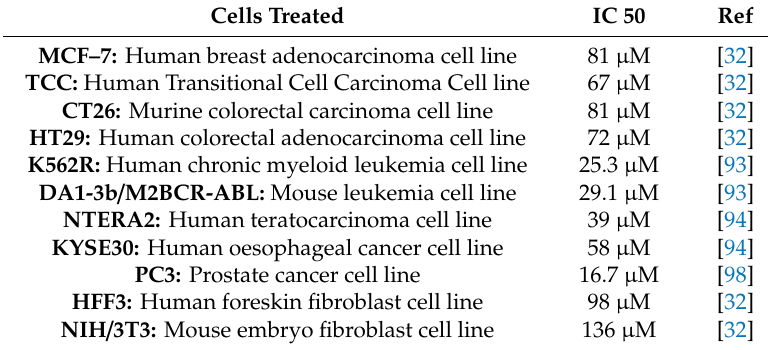
Table 1. IC50 values of di ff erent types of cell lines, tumor and healthy respectively, treated with ferutinin. Cells Treated IC 50